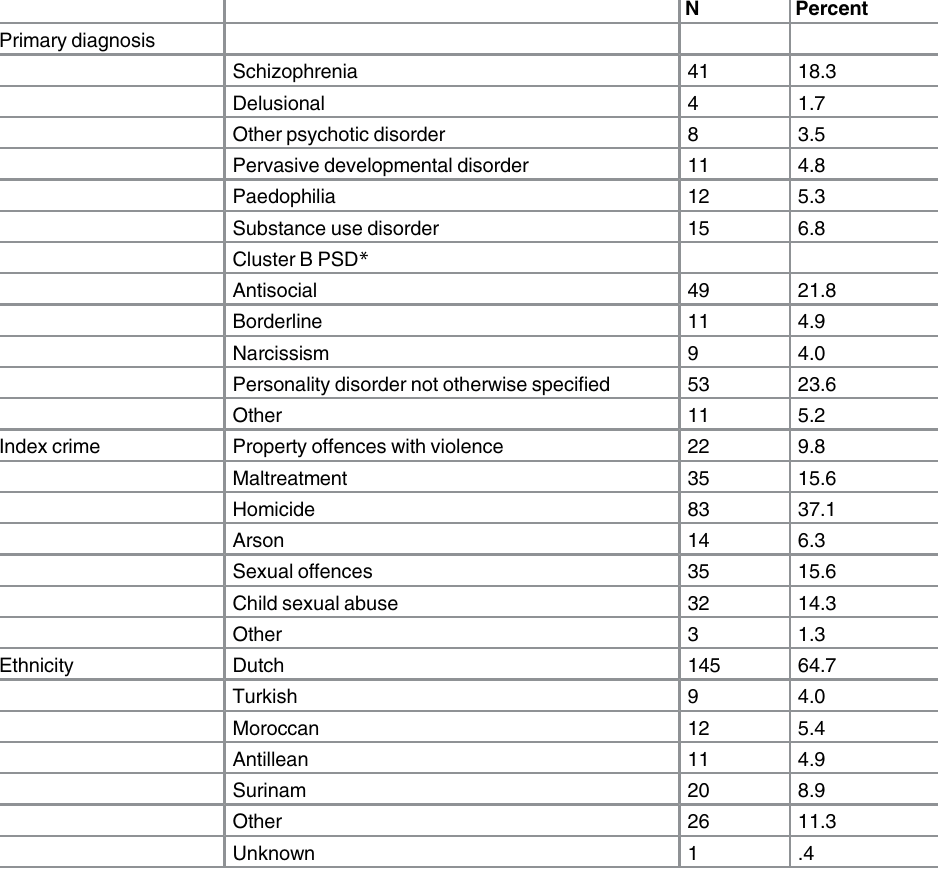
Table 1. Patient characteristics, primary diagnoses, index crime and